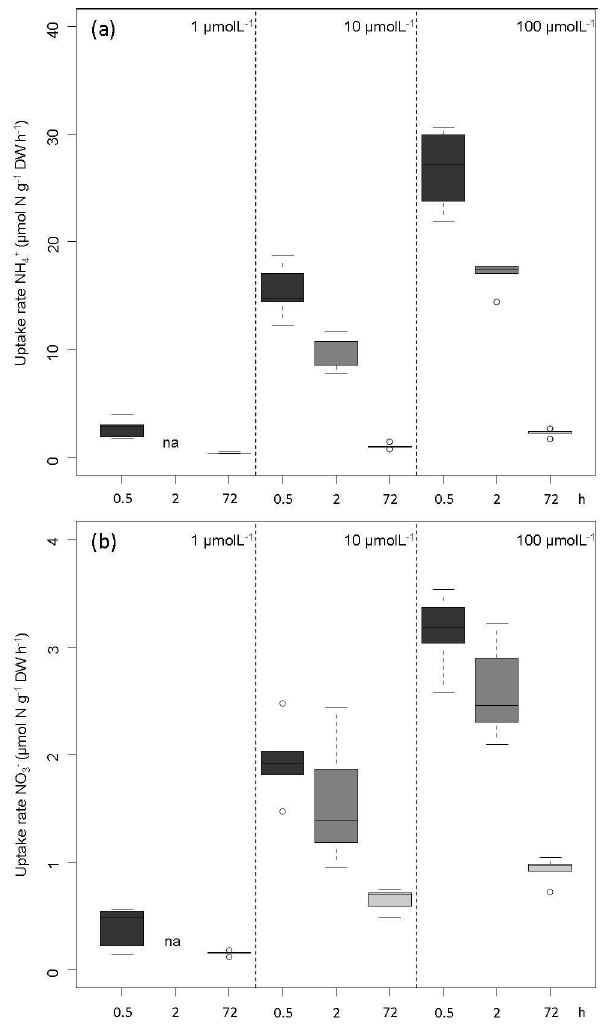
Figure 2. Average uptake rates ( m mol N gDW 2 1 h 2 1 ) after 0.5 (dark grey), 2 (grey) and 72 (light grey) hours, respectively in Sphagnum magellanicum ( n =5) from the pristine site (Argen- tina). The upper panel (a) shows ammonium (NH 4 + ) uptake, the lower panel (b) nitrate (NO 3 2 ) uptake.